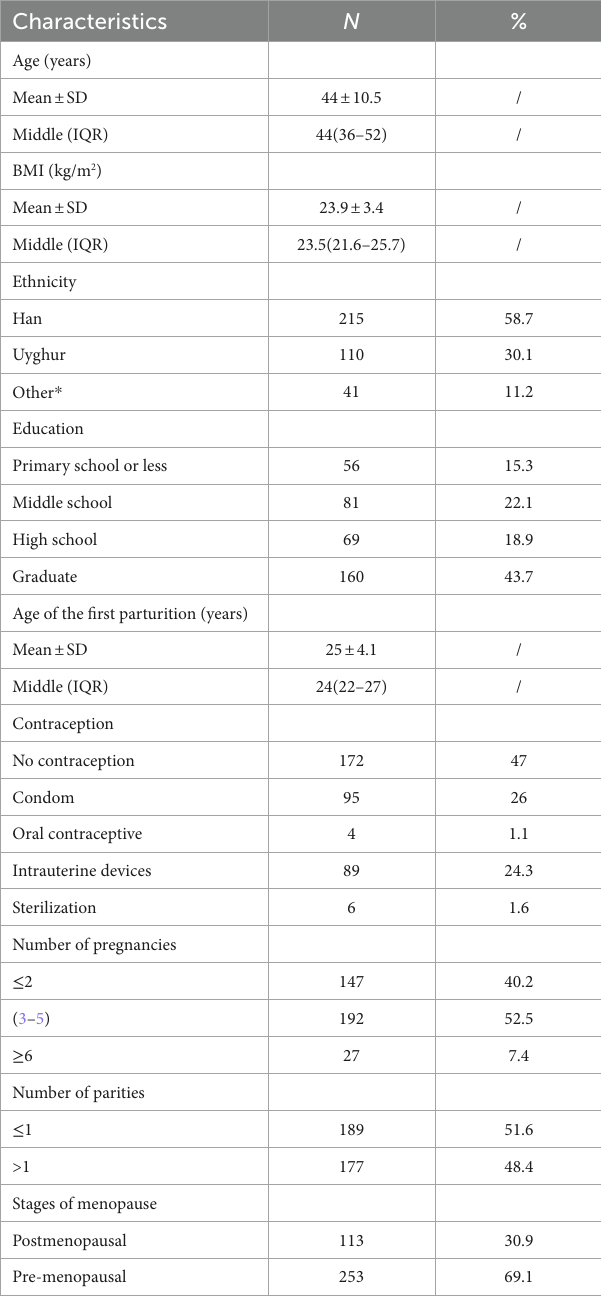
TABLE 1 Demographic characteristics of the study population.